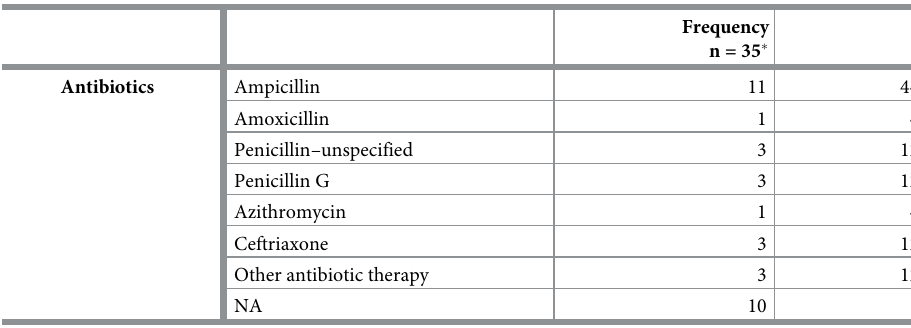
Table 8. Antibiotic